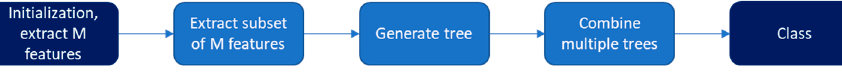
Figure 4. Indicative example of RF steps.